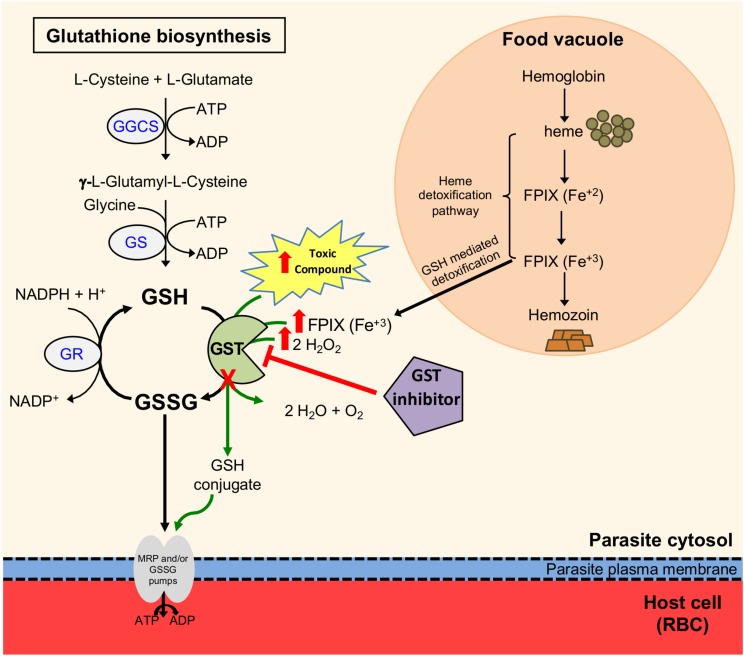
Predicted model of disruption or inhibition of the glutathione S-transferase in P. berghei intra-erythrocytic stages. The diagram shows the glutathione (GSH) redox system in P. berghei intra-erythrocytic stages. GSH is recycled by glutathione reductase (GR) and glutathione S-transferase (GST), which maintain the balance between GSH and oxidized glutathione (GSSG). GST functions include: GSH conjugation to toxic compounds, GSH mediated detoxification of ferriprotoporphyrin IX (FPIX) where GST serves as a ligandin and detoxification of hydrogen peroxide (depicted as green arrows). GST conjugates GSH to a variety of compounds containing electrophilic centers forming GSH conjugates that are recognized and exported by multidrug resistance-associated protein (MRP) and/or GSSG pumps. Hemoglobin digestion in the food vacuole forms heme, which is converted into hemozoin crystals through the heme detoxification pathway. A portion of heme is transported to the parasite’s cytosol where it is conjugated to GSH by GST for its detoxification. Genetic or chemical disruption of PbGST interferes with their detoxification, resulting in accumulation of toxic compounds, including H2O2 and FPIX (represented by red arrows), leading to parasite death.